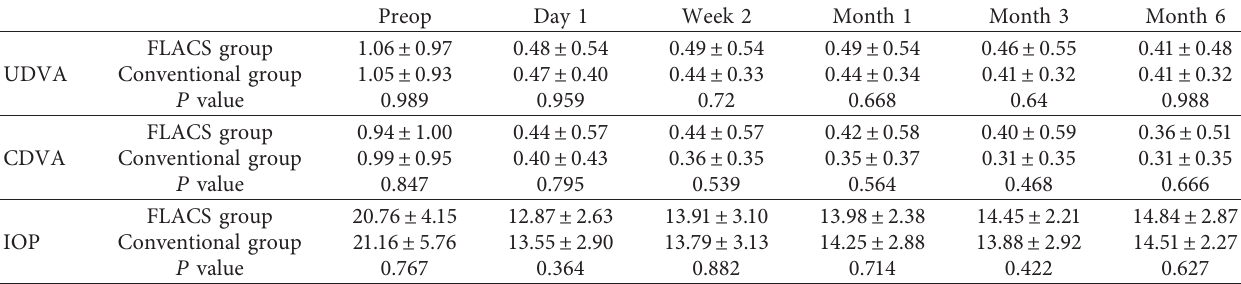
Table 2: Pre- and postoperative UDVA, CDVA, and IOP between the two groups at different time points.